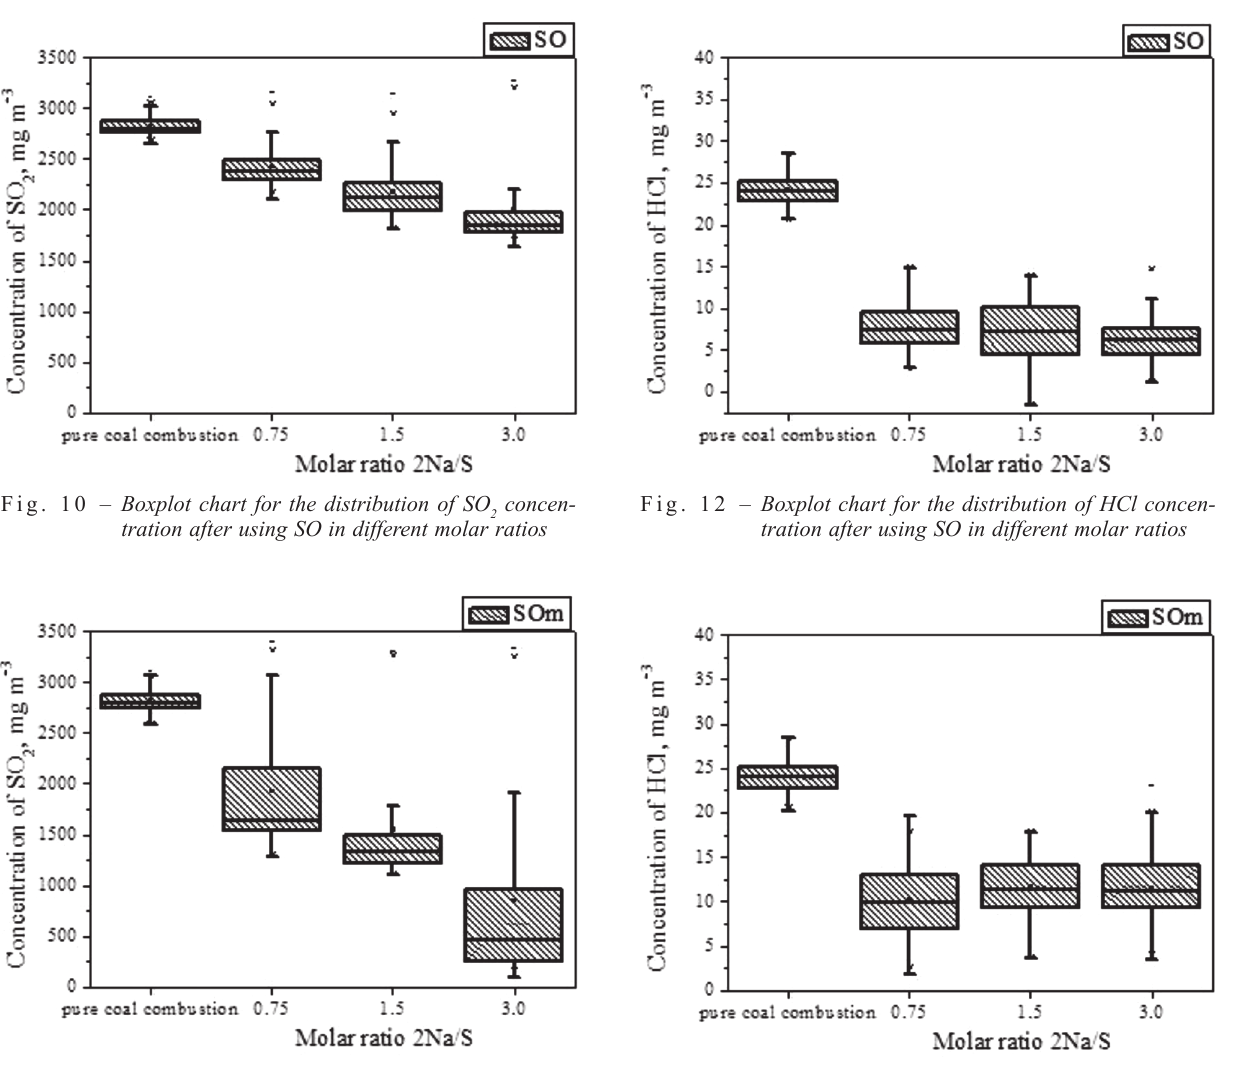
concen- Fig. 13 – Boxplot chart for the distribution of HCl concen- 2 tration after using SOm in different molar